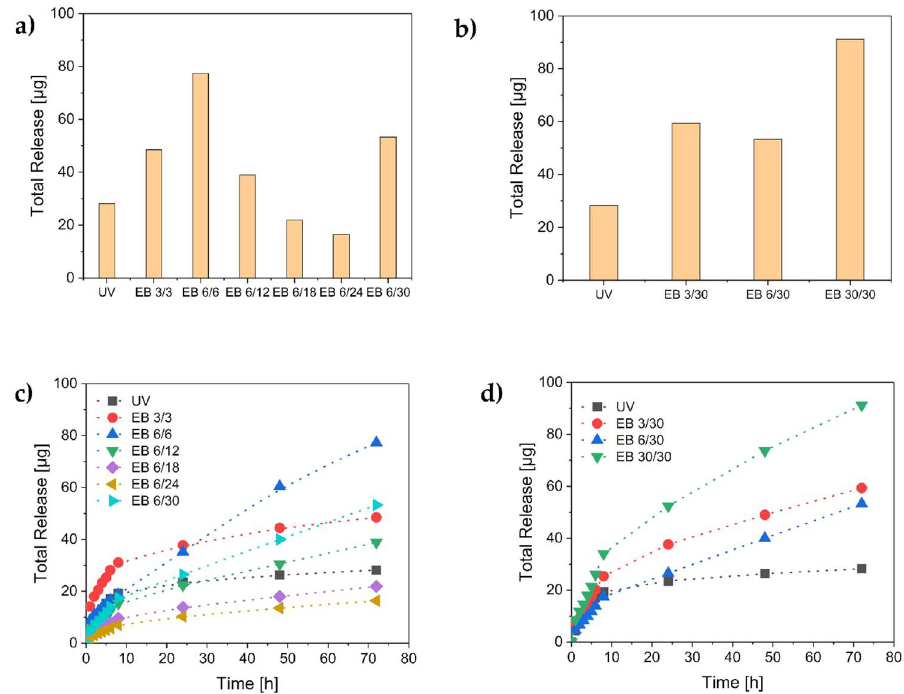
Figure 6. The release of methylene blue from the hydrogels. Total release of the hydrogels with the variation of ( a ) the total doses and ( b ) the differential doses. Time-dependent release behavior of ( c ) the total doses and ( d ) the differential doses.